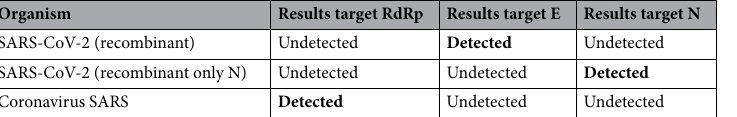
Table 1. Specifity evaluation of our kit using NATtrol SARS-CoV-2 (E/ORF1ab recombinant), NATtrol SARS- CoV-2 and NATtrol Coronavirus